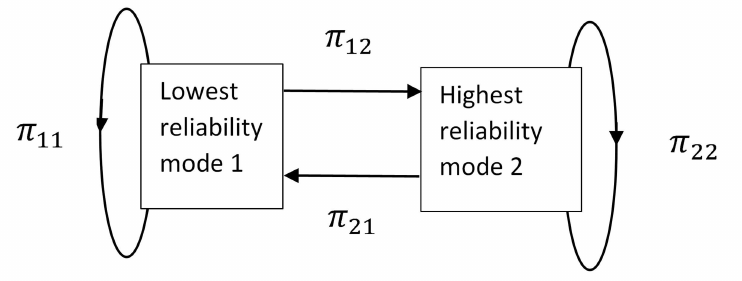
Figure 5. State-space diagram of the highest and lowest reliability modes.